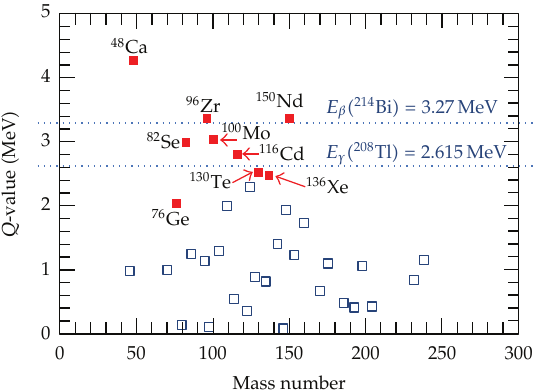
Figure 8: Double-beta decay candidates and their Q -values (cid:2) adapted from (cid:5) 52 (cid:6)(cid:3) . The “magnificent nine” are highlighted and two background-relevant energy markers are indicated (cid:2) see text (cid:3) . Table 4: Relevant parameters and features of the “magnificent nine” double-beta decay candidates.